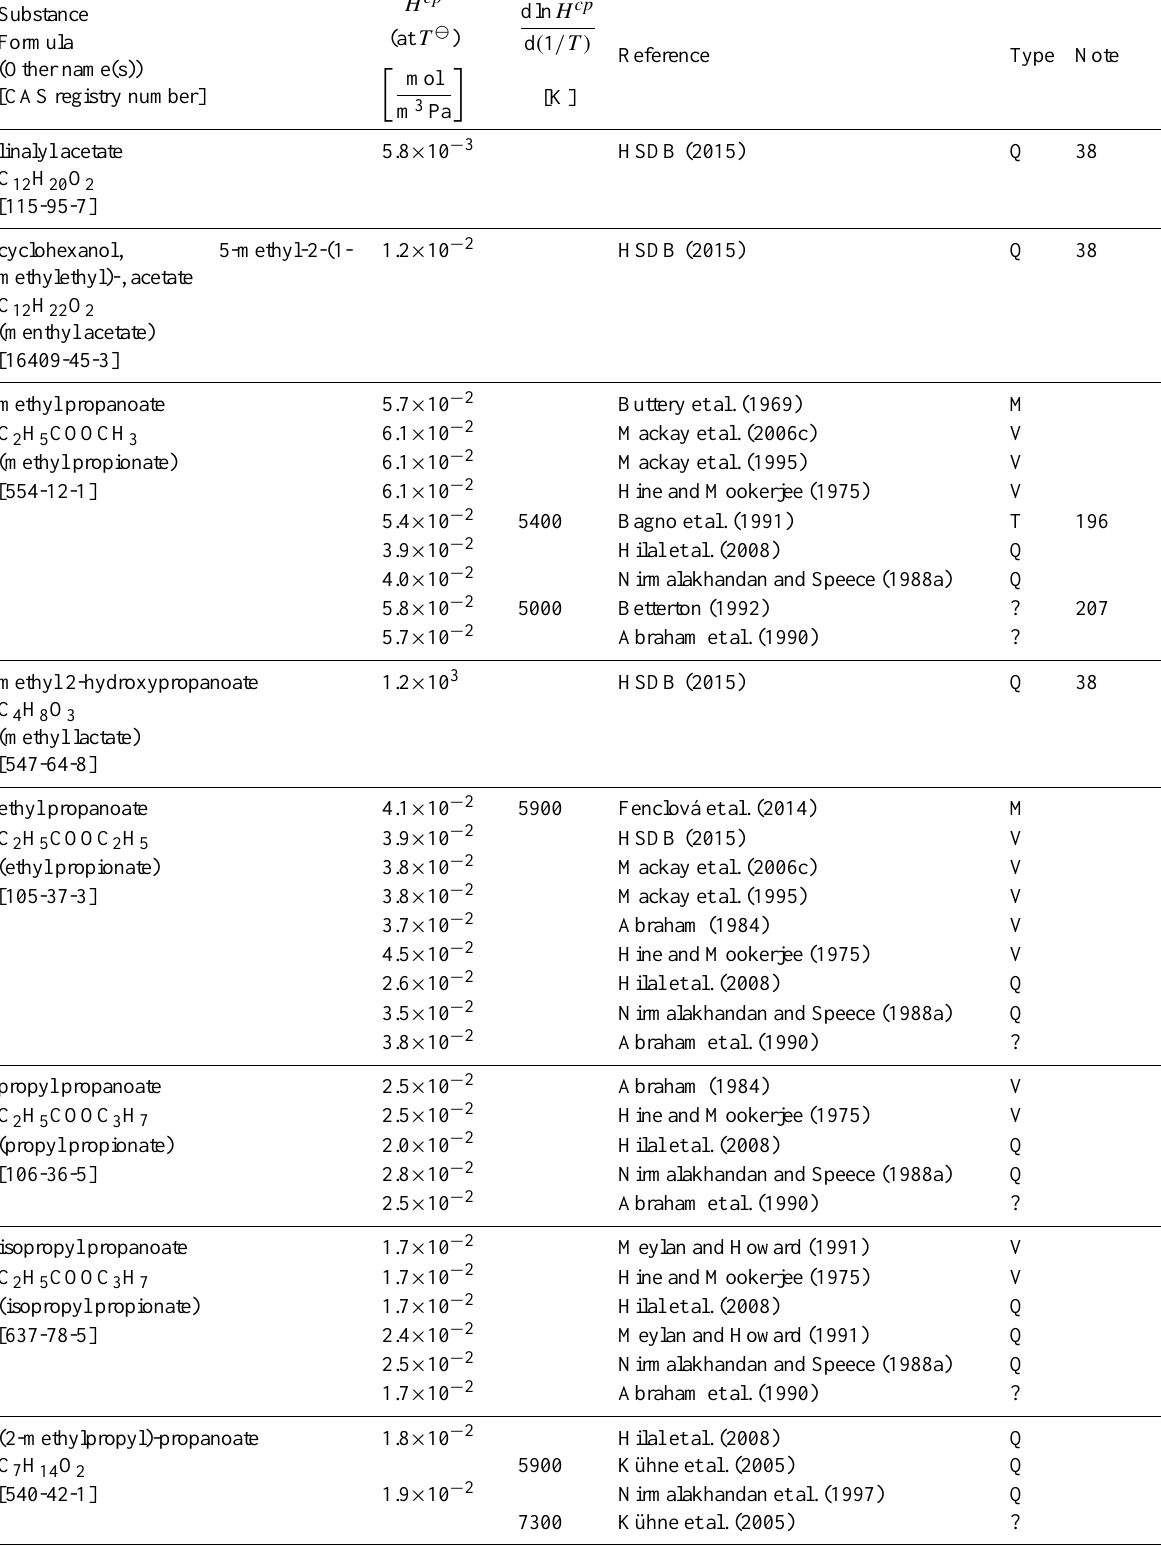
Table 6: Henry’s law constants for water as solvent